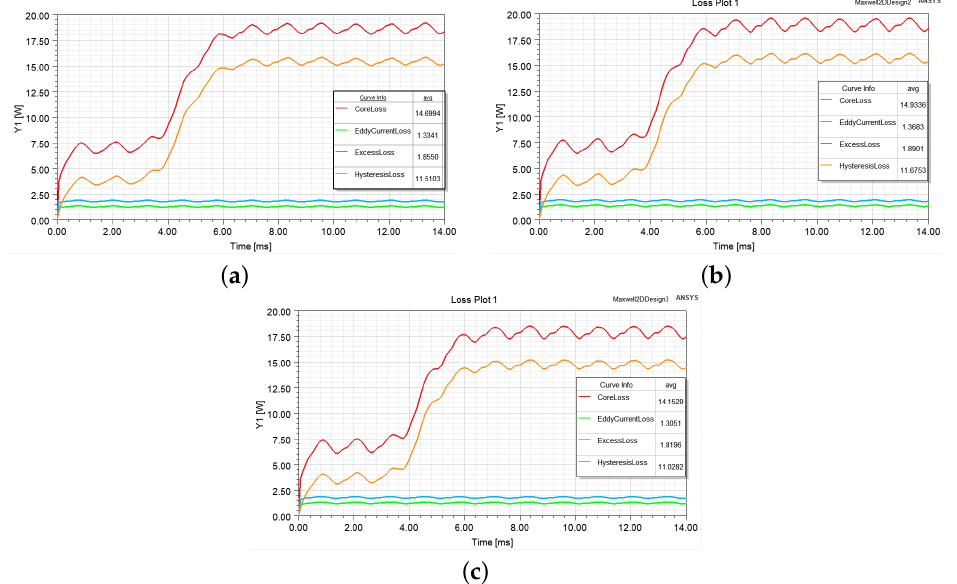
Figure 16. Stator core losses for ( a ) Slot − 1, ( b ) Slot − 2, and ( c ) for Slot − 3.